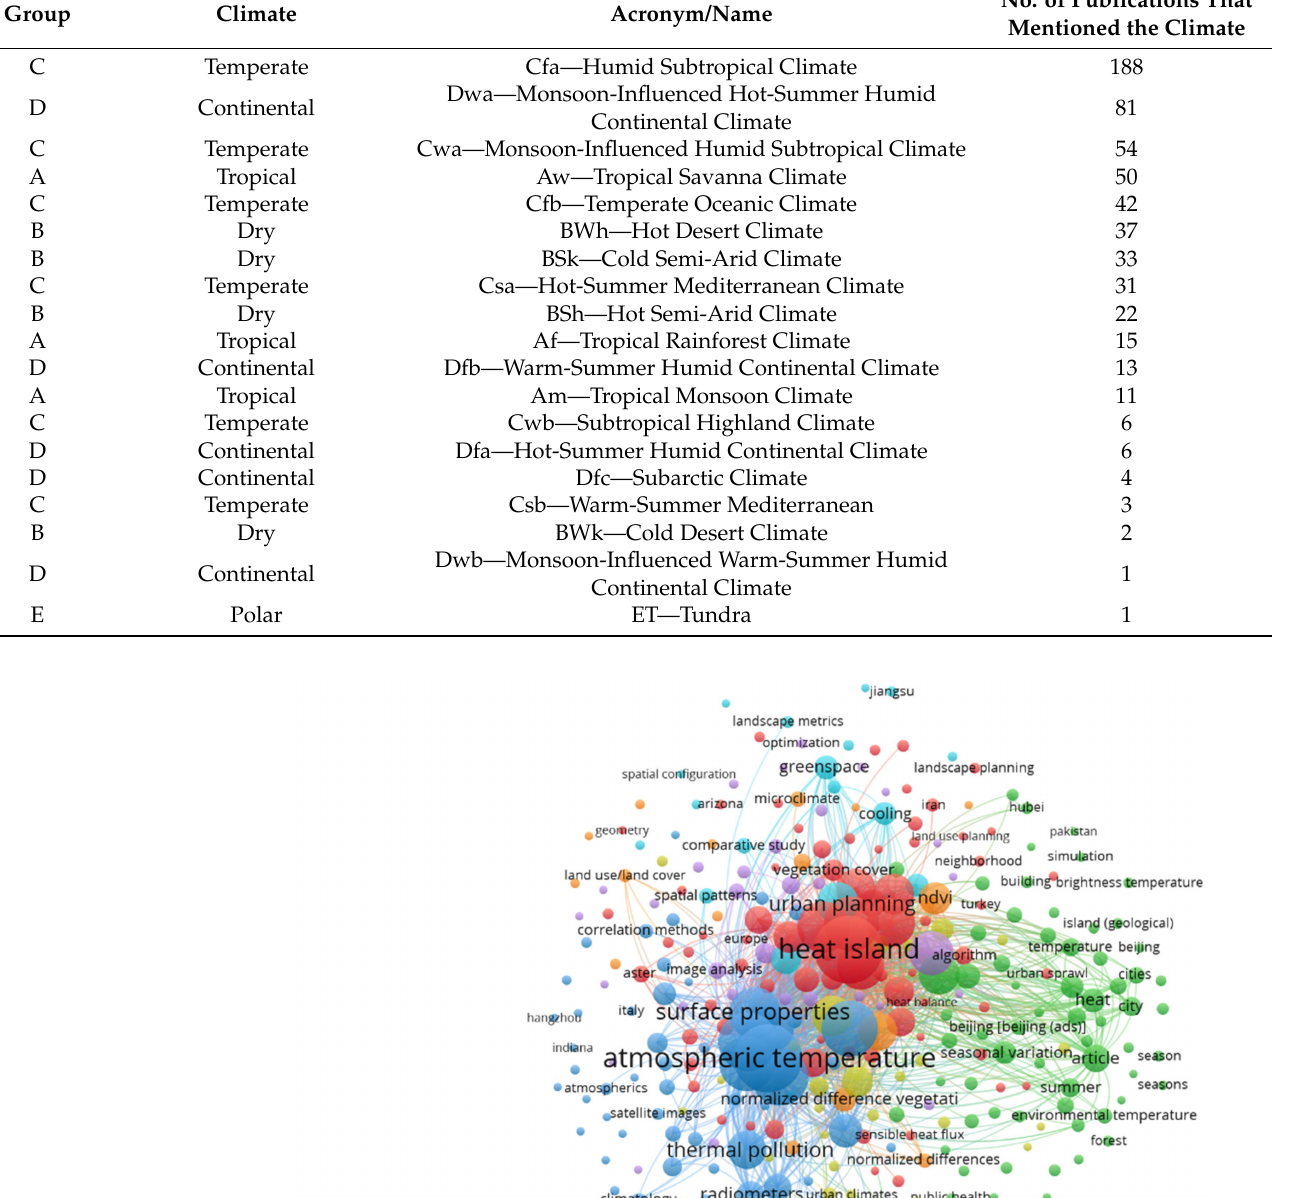
Table 3. Climatic zone of study areas.